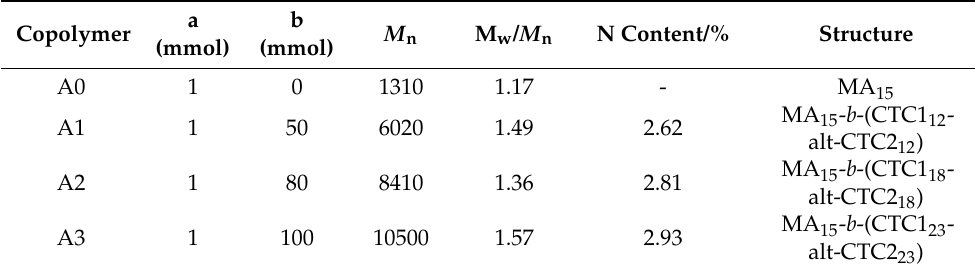
Table 3. The copolymer composition under various proportions between PMA and